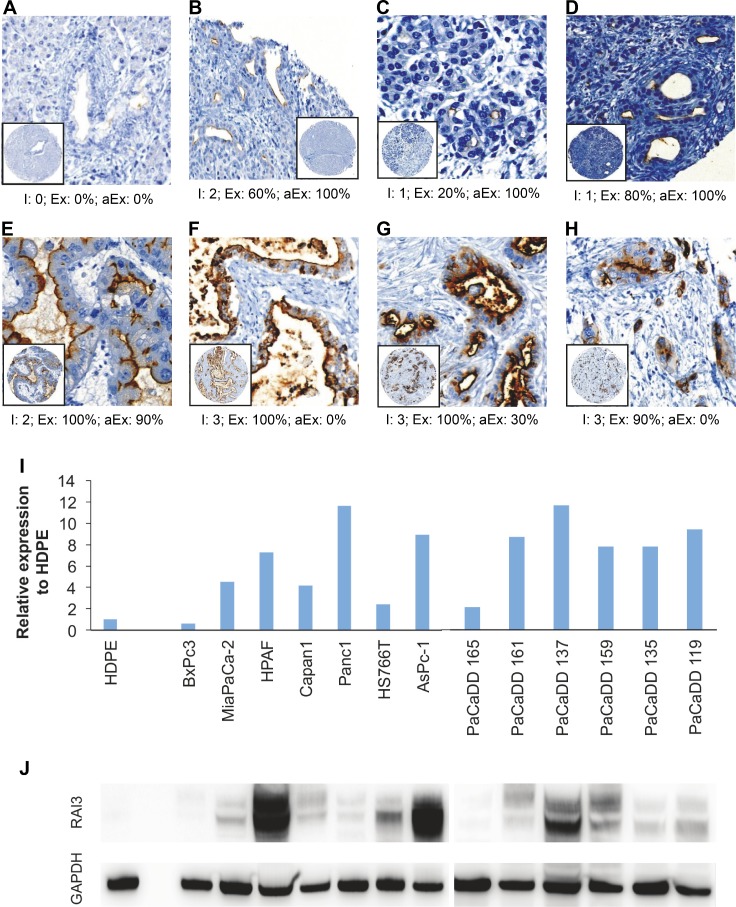
Expression of RAI3 in human tissue and cell lines.TMA—Immunochemistry with RAI3-Antibody in different types of pancreatic tissue. Presentation in 20-fold magnification of A-C: Normal; D: Chronic pancreatits (CP), E: Intraductal Papillary Mucinous Neoplasm (IPMN); F—H: Pancreatic Ductal Adenocarcinoma (PDAC). Three parameters were considered: RAI3-Intensity (I), RAI3-Expression (Ex) and Apical RAI3-Expression (aEx); I,J: Differential expression of RAI3 mRNA respective protein in common pancreatic cell lines and primary pancreatic cell lines measured by qRT-PCR (I) and Western Blot (J) with a conspicuously low expression in BxPc3 and PaCaDD165 in comparison to the other cell lines in the group. (n = 3).